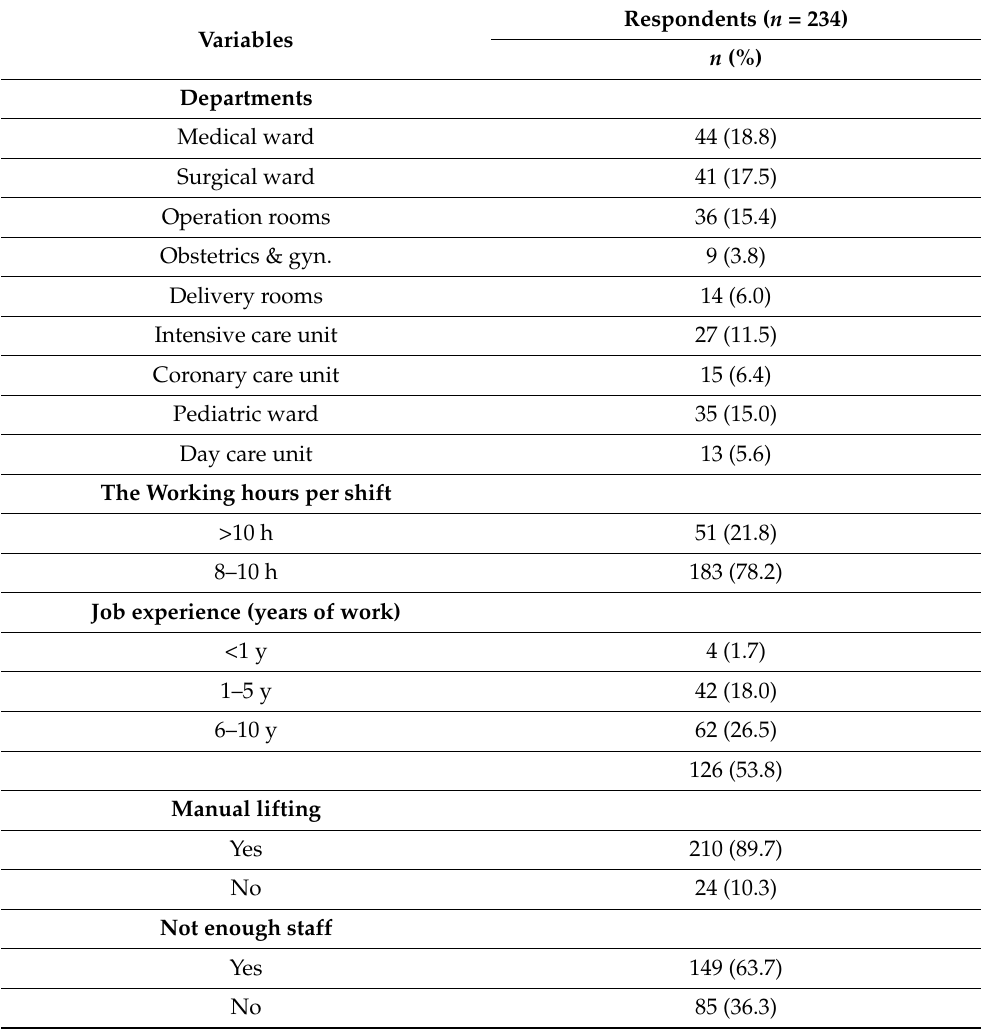
Table 3. Work-related Factors of the